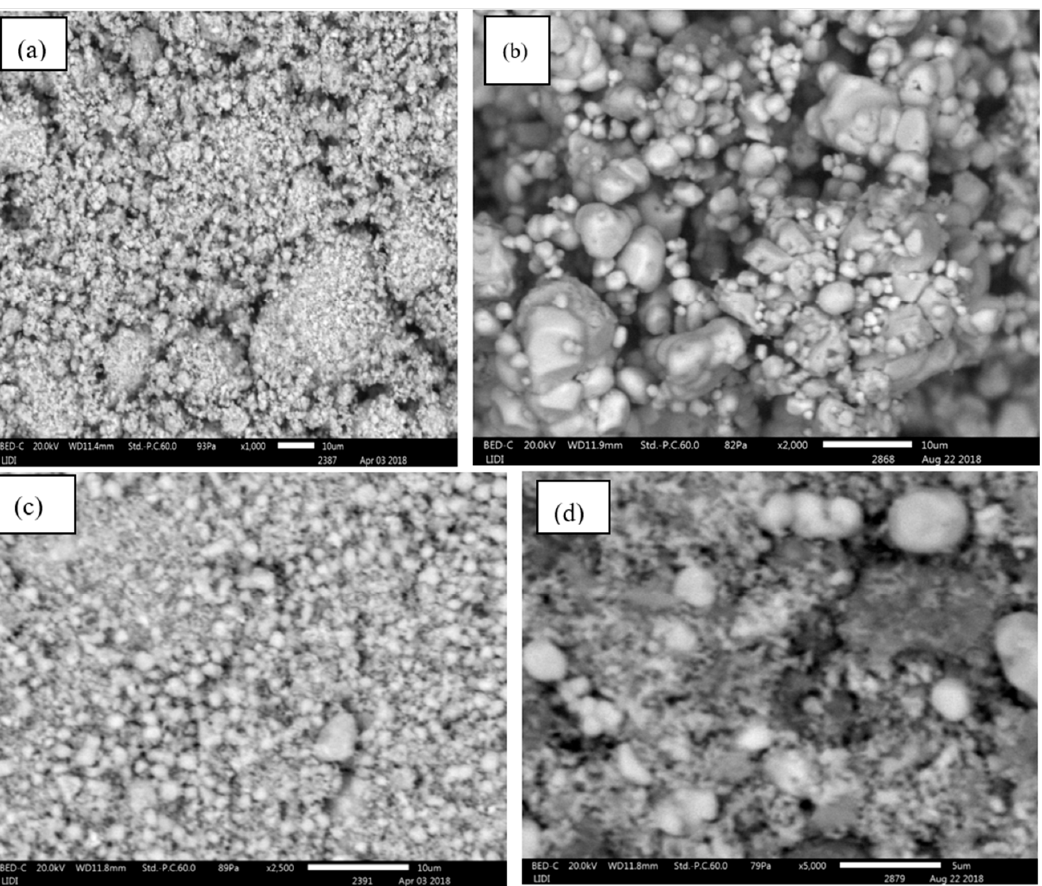
Figure 2. Scanning electron microscopy (SEM) morphology of ( a ) ZnO, ( b ) Cu 2 O, ( c ) Cu 2 O / ZnO and ( d ) N-doped Cu 2 O / ZnO nanomaterials .